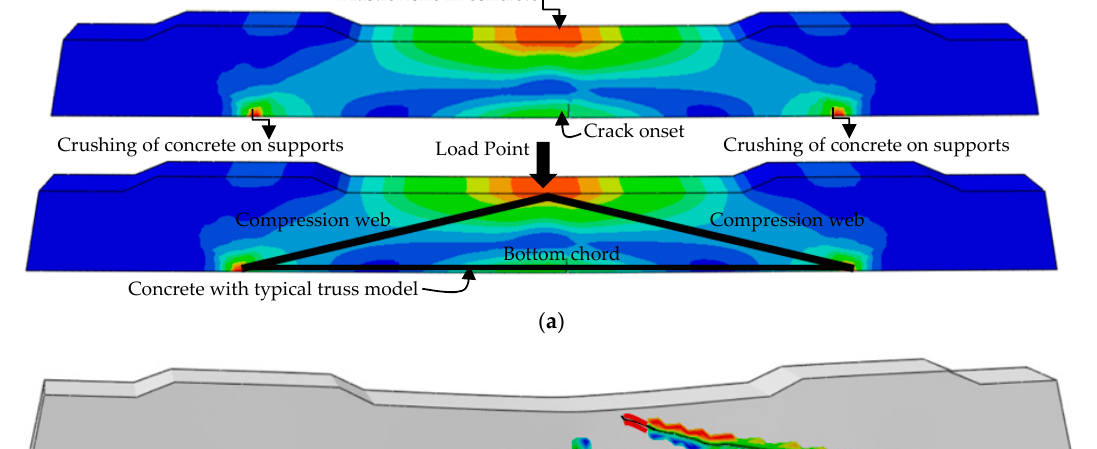
Figure 13. Comparison of vertical displacements ( U z ), determined through experimental tests and numerical analysis: ( a ) load at sleeper support; and ( b ) load at midspan.